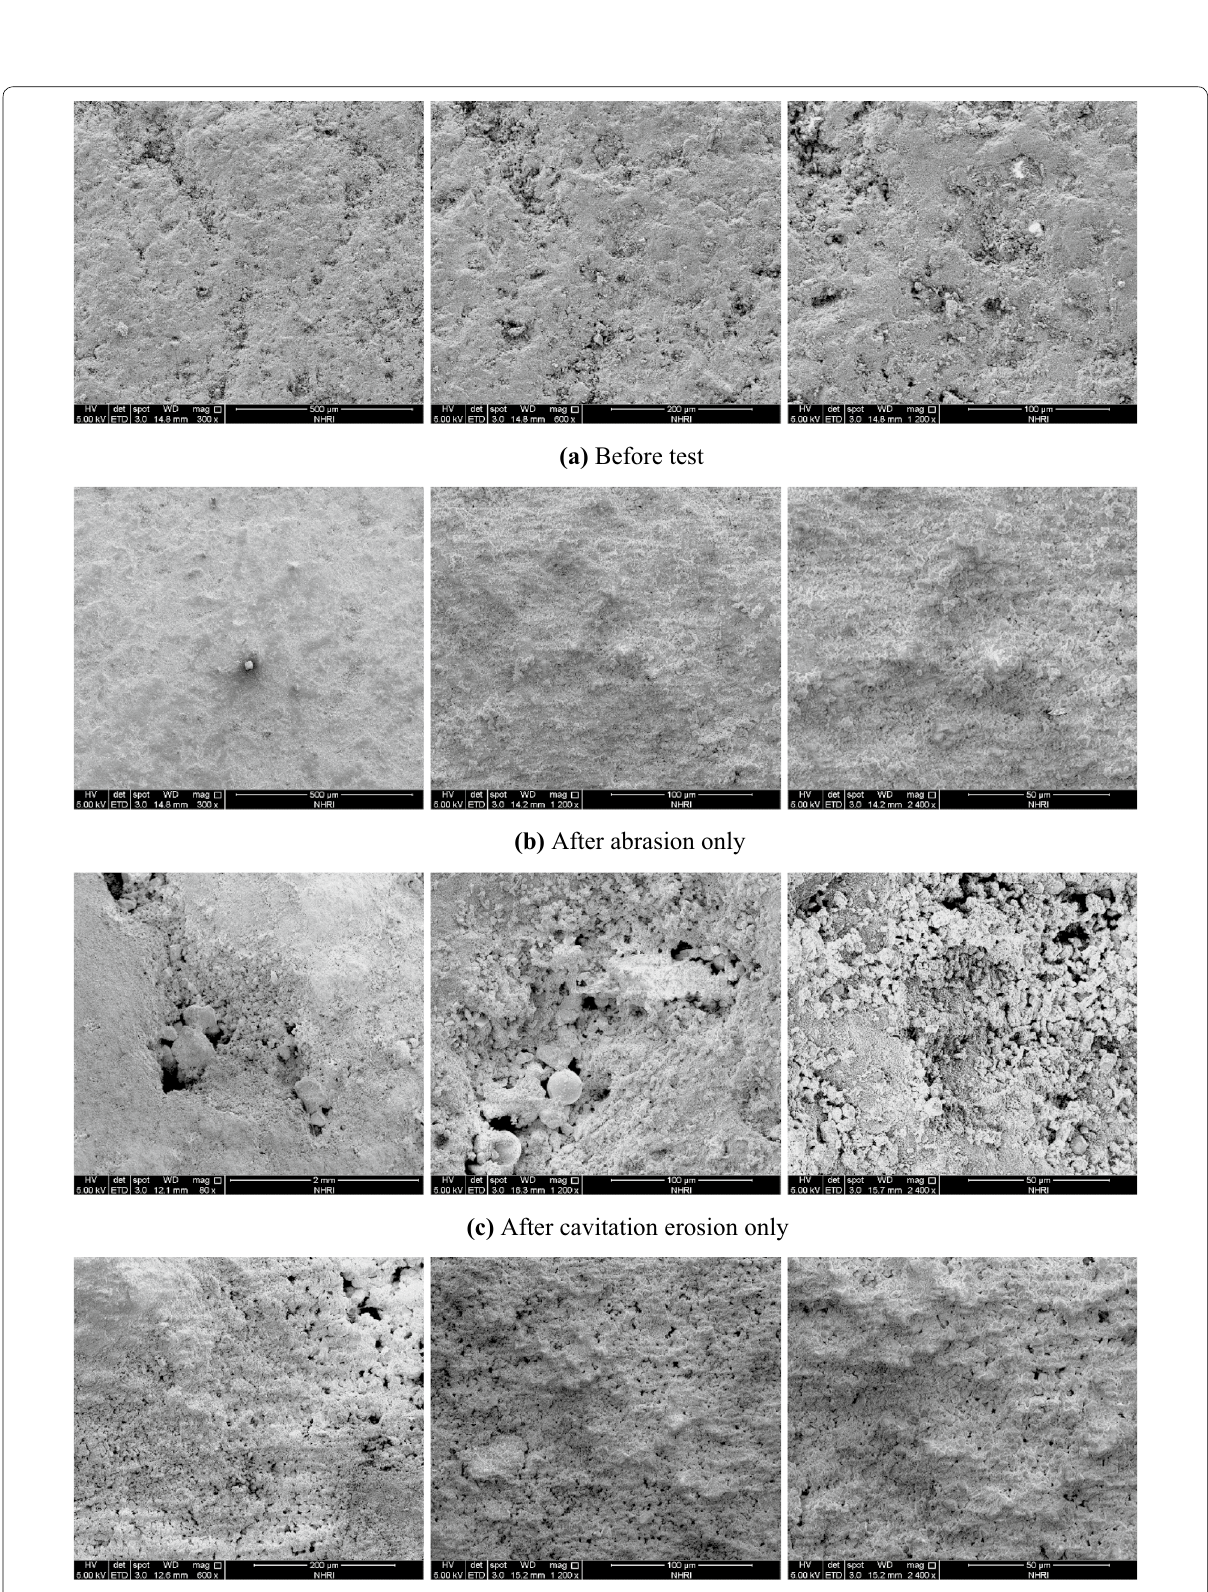
Fig. 13 Micro-morphology of specimen